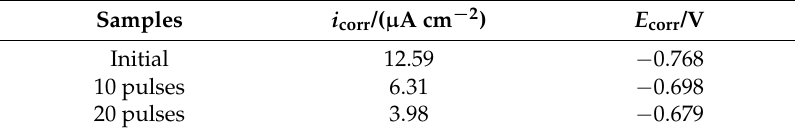
Figure 9. The polarization curve of the initial and HCPEB-alloyed Cr–Ni samples in 3.5 wt.% NaCl solution. Table 2. The corrosion data of the unalloyed and alloyed samples.